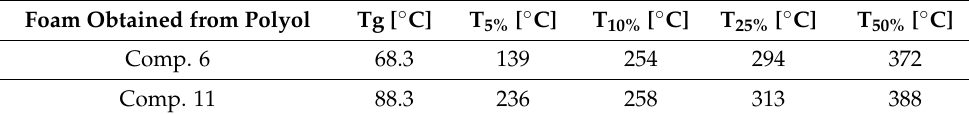
Table 8. Thermal analysis of foam determined by dynamic method.